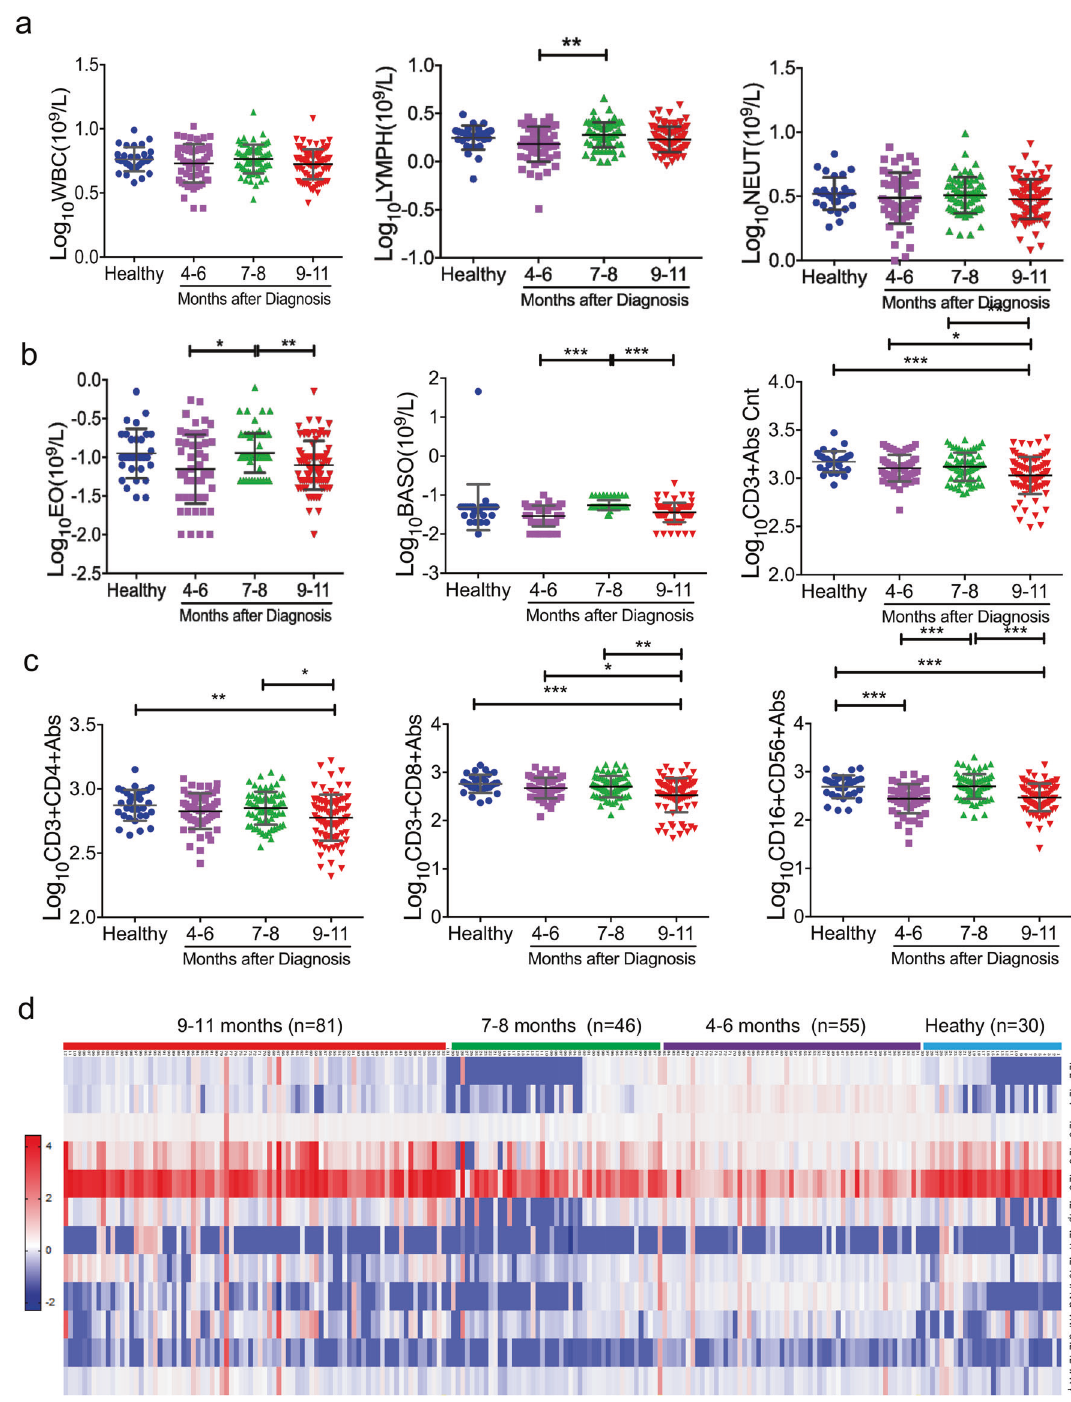
Fig. 2 Dynamic changes in lymphocyte subsets and cytokines in COVID-19 convalescent individuals. The routine hematological examination was performed using standard methods in our hospital. Routine peripheral blood cells, including WBC, lymphocytes, neutrophils, eosinophils, and basophils, were analyzed. Lymphocyte subsets were analyzed in COVID-19 convalescent individuals ( a – c ). A total of 12 kinds of cytokines were analyzed in COVID-19 convalescent individuals by fl ow cytometry ( d ). Samples were organized by the time course after the symptom onset, which is indicated on the top side of the PHA stimulated-cytokines (Fig. 5b). Furthermore, COVID-19 con- valescent individuals showed accompanying antigen peptide pools stimulated-IL-2 response, -IFN- γ response, and -IL-5 response (Fig. 5c). These data suggested that antigen peptide Table 3). By Kaplan – Meier analysis and the log-rank test, antigen pools stimulated-IL-2 and -IFN- γ could distinguish COVID-19 peptide pools stimulated-IL-2 and -IFN- γ positive responses were convalescent individuals from healthy donors.